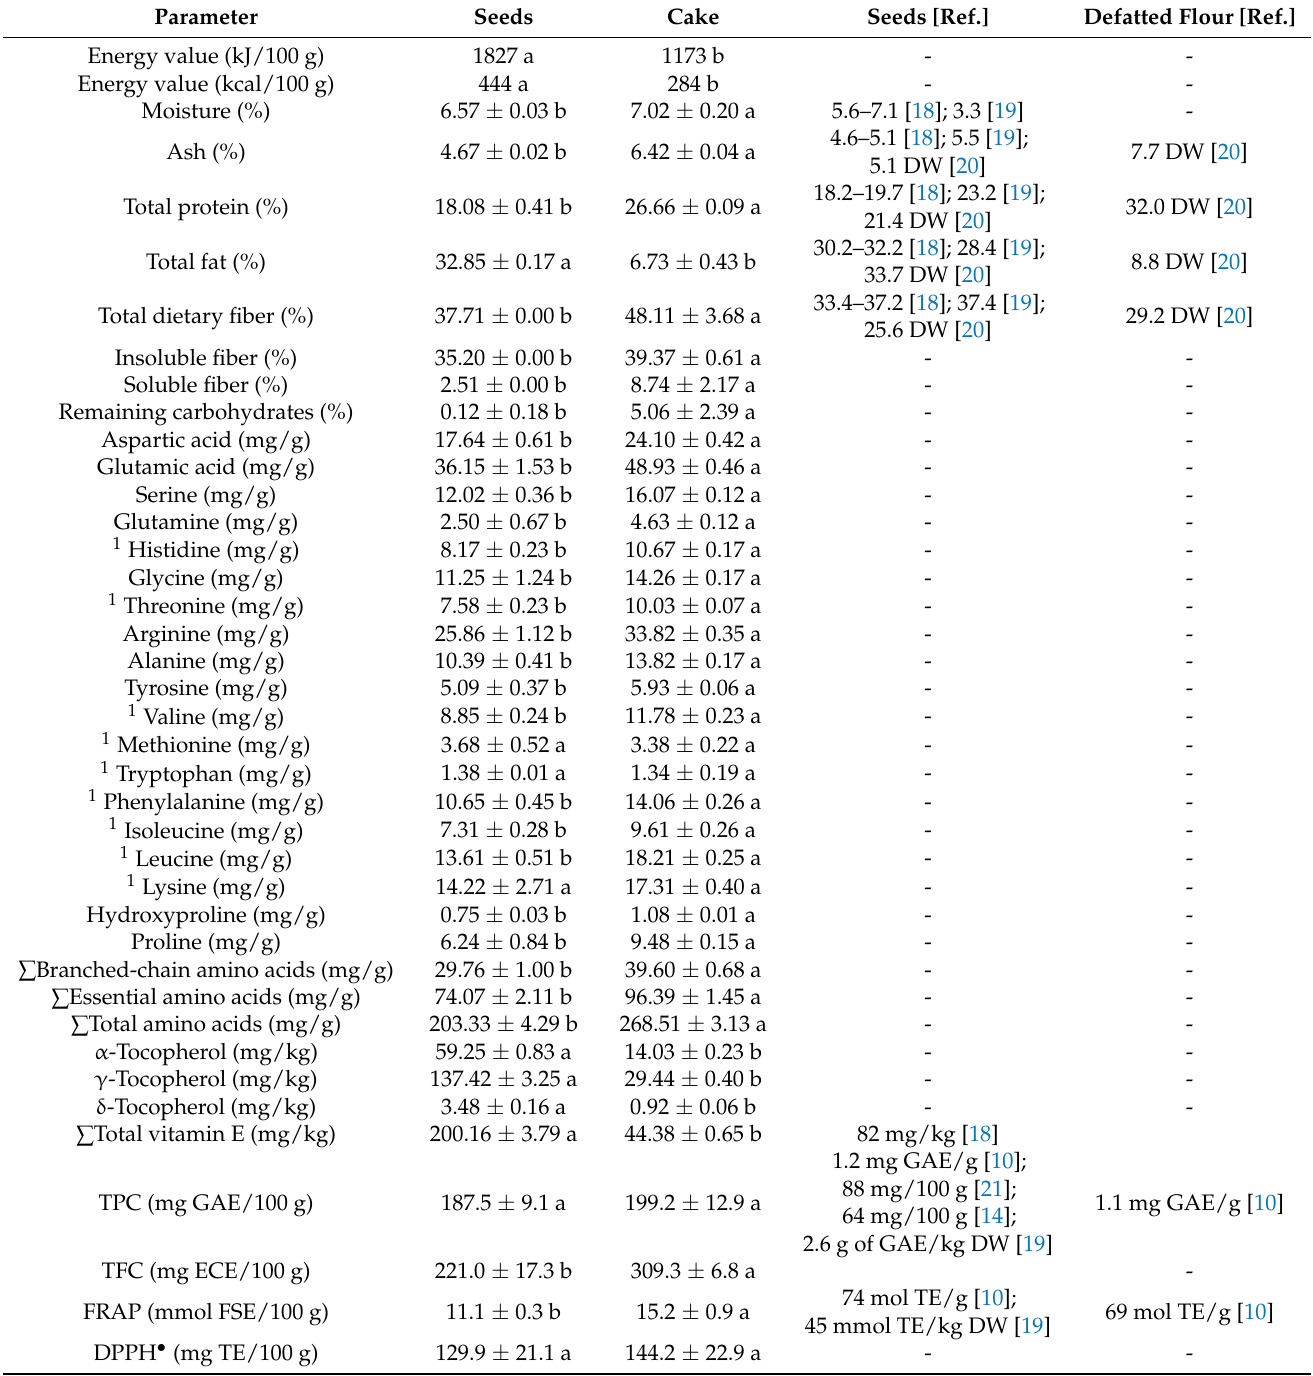
Table 3. Chemical analysis of chia seeds, cake, and literature data. Seeds Cake Seeds